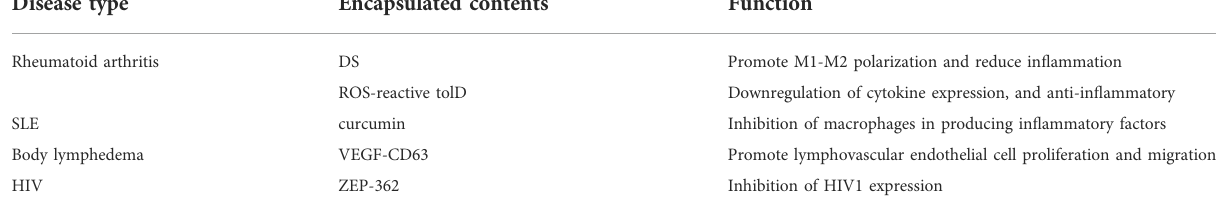
TABLE 8 Engineered exosomes in the immune system.